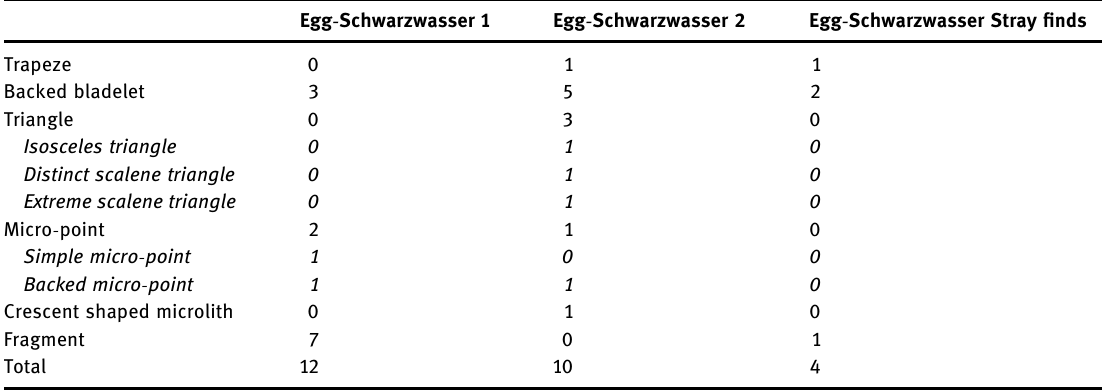
Table 3: Microlith types Egg - Schwarzwasser Egg - Schwarzwasser 1 Egg - Schwarzwasser 2 Egg - Schwarzwasser Stray fi